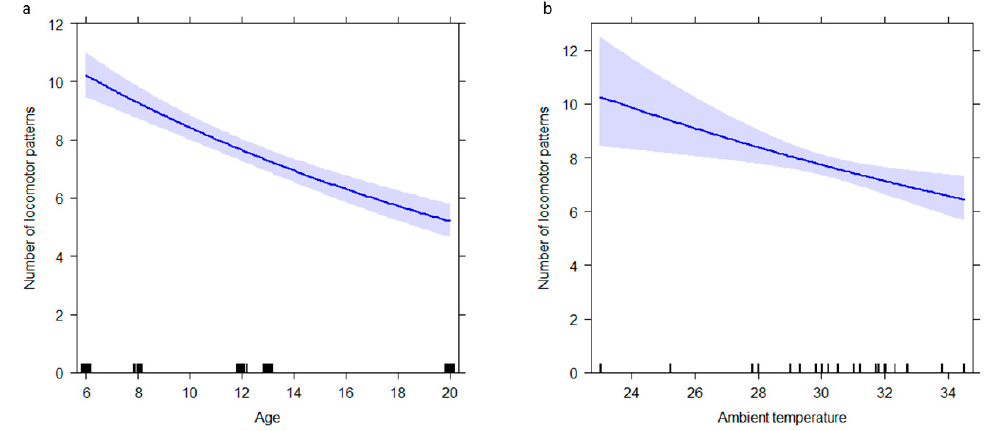
Figure 2. Effect plot of variables having a significant influence on the number of locomotor patterns. The number of locomotor patterns (Y axis): ( a ) decreases as the age of individuals (X axis) increases, ( b ) decreases as the ambient temperature (X axis) increases. The band represents the confidence interval. For GLM 2 (target variable: resting ), the full model did not differ from the null model (likelihood ratio test: χ 2 = 13.057, df = 16, p = 0.669; Nagelkerke’s pseudo R squared =